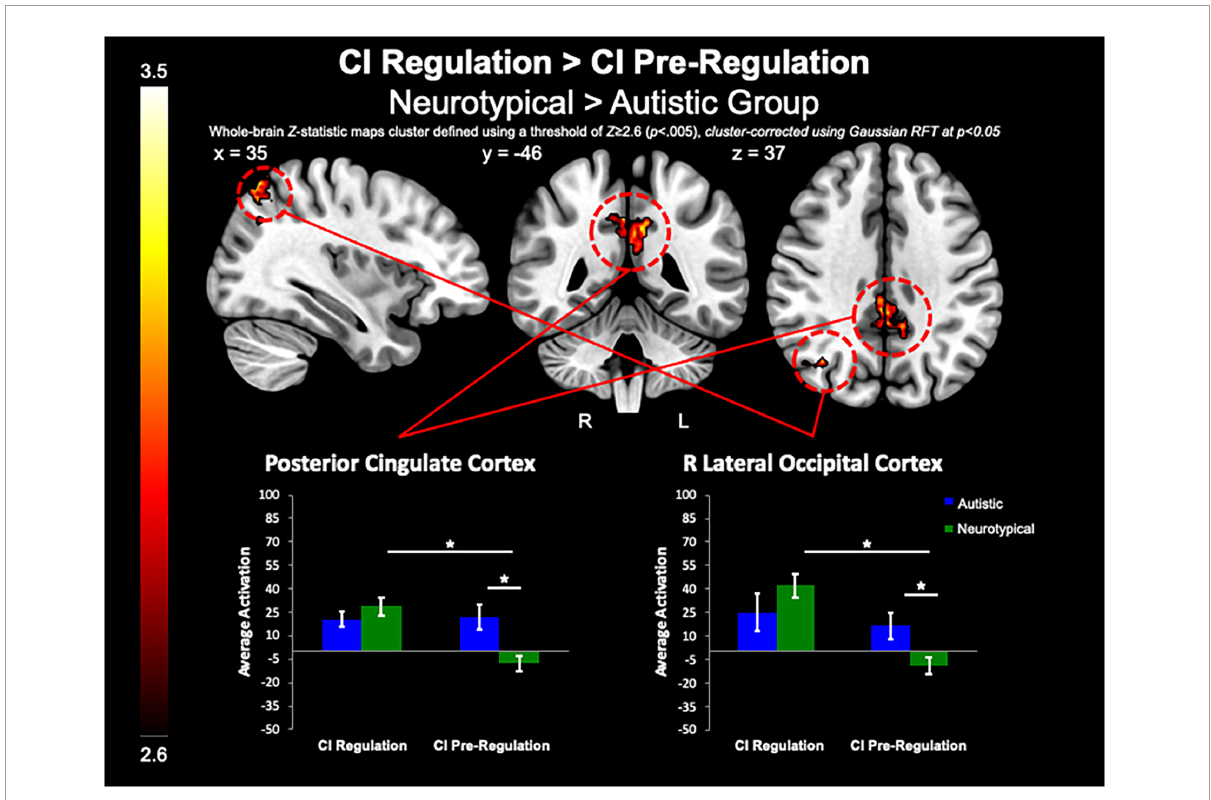
FIGURE4 CI regulation > CI pre-regulation. Compared to controls, the autistic group demonstrated decreased activation in the PCC and R lateral occipital cortex when regulating CI images vs. viewing CI